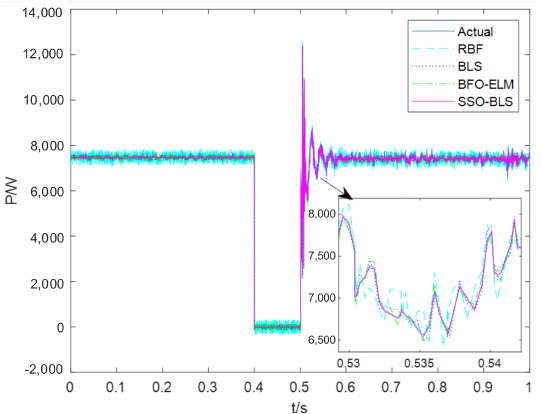
Figure 7. Power comparison of different equivalent models when the DC microgrids load is reduced by